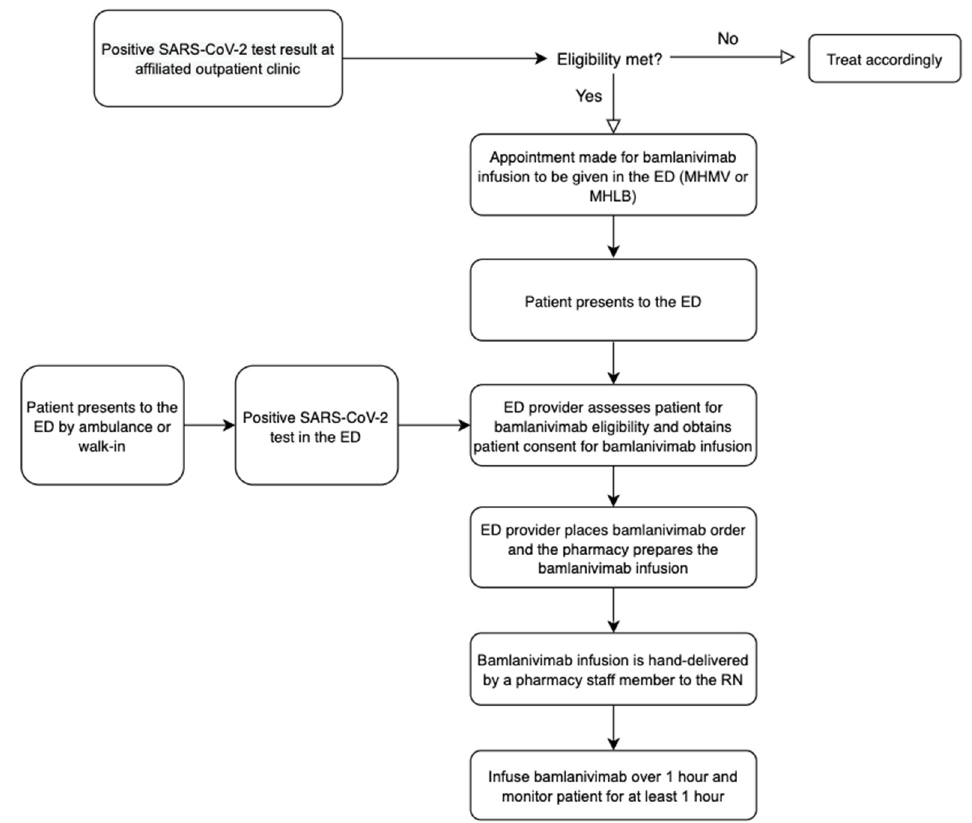
Figure 1. Workflow for bamlanivimab infusion in the ED of Providence MHMV and MHLB.